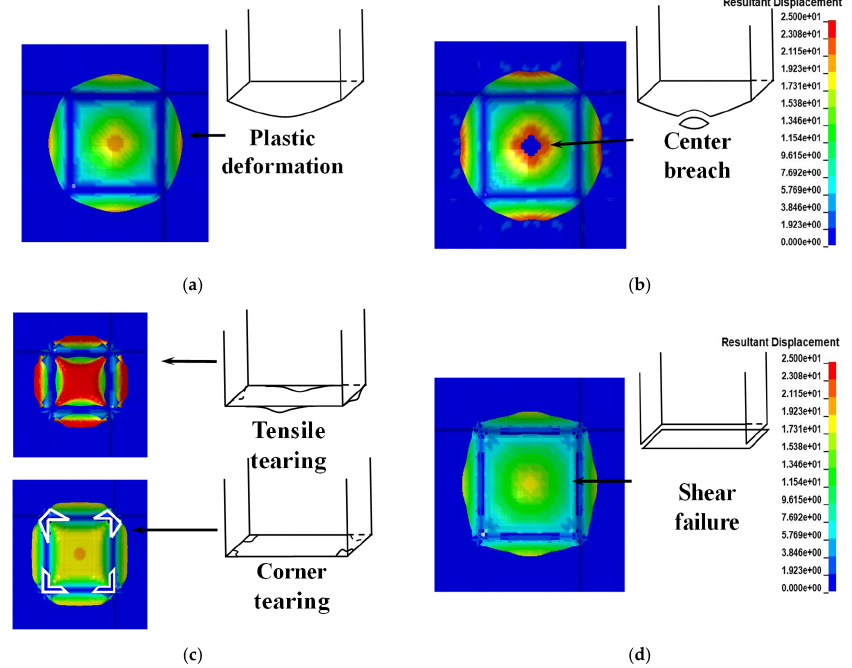
Figure 4. Failure modes of the blast-loaded cabin: ( a ) Mode I Plastic deformation ( W = 3 kg, t = 2.50 × 10 -3 s); ( b ) Mode II Center breach ( W = 6.25 kg, t = 4.65 × 10 -3 s); ( c ) Mode III Tensile tearing ( W = 11 kg, t = 1.05 × 10 -3 s, W = 15 kg, t = 1.35 × 10 -3 s); ( d ) Mode IV Shear failure ( W = 55 kg , t = 0.45 × 10 -3 s). tearing ( W = 11 kg, t = 1.05 × 10 − 3 s, W = 15 kg, t = 1.35 × 10 − 3 s); ( d ) Mode IV Shear failure ( W = 55 kg, t = 0.45 × 10 − 3